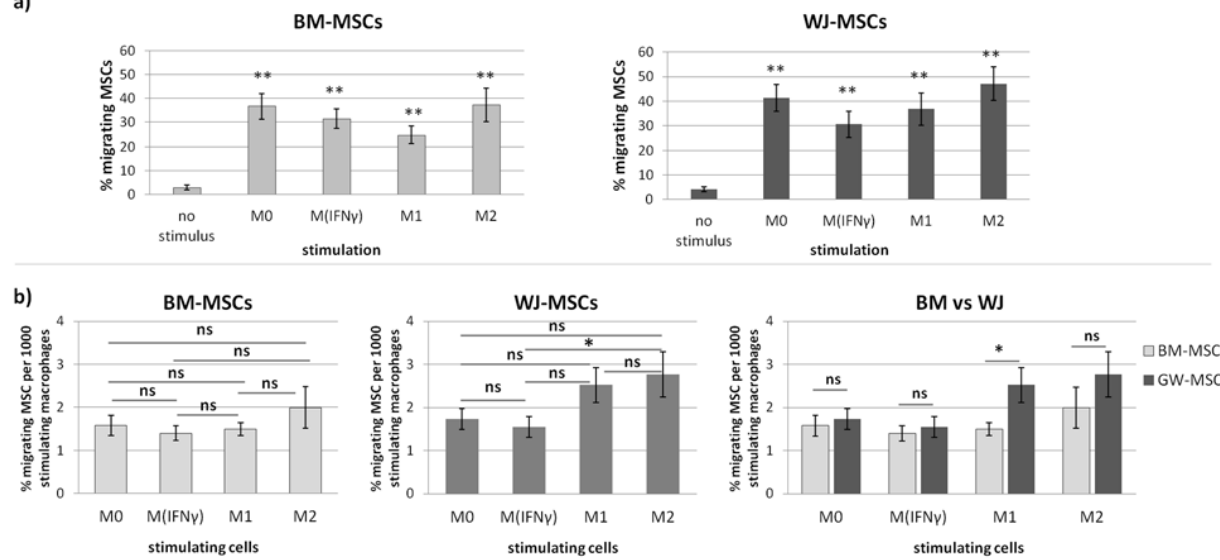
Figure 8. The effect of different subsets of macrophages on the chemotactic activity of human BM-MSCs and WJ-MSCs assessed using the trans-well migration assay (8 μ m). ( a ) The migrating BM-MSCs and WJ-MSCs stimulated by different subsets of macrophages (M0—unstimulated macrophages, M IFN γ —IFN γ stimulated, M1—IFN γ /LPS-stimulated, and M2- IL-4/IL-10 stimulated) macrophages in comparison to the unstimulated control (no stimulus—migration to the empty well). Bars represent the mean percentage (± SEM) of MSCs found in the lower compartment after 48 h (with respect to the number of cells seeded in the upper compartment at the start of the experiment); Data analyzed using T-test for related data in comparison to unstimulated control; ** p < 0.01. ( b ) The comparison of different subsets of macrophages as stimu- lants of MSCs chemotaxis. The data presented as the mean percentage (± SEM) of MSCs found in the lower compartment after 48 h (with respect to the number of cells seeded in the upper compartment at the start of the experiment) per 1000 stimulating cells. Within one MSC type, data were analyzed using one-way ANOVA with Tukey post-hoc correction. The comparison of BM-MSCs and WJ-MSCs within one stimulus was performed using a T-test for independent data (normal data distribution in all groups confirmed with Shapiro–Wilk test). * p < 0.05; ns—statistically not significant. Data collected from 4 independent experiments, total n = 12. This basal rate of migration did not differ significantly between BM-MSCs and WJ- MSCs ( p > 0.05) (Figure 8a). If macrophages (M0, M IFN γ , M1, or M2) were used as stimu- lants, the percentage of migrating BM-MSCs increased to 36.6%, 31.4%, 24.8%, and 37%, respectively ( p < 0.01 for all groups in comparison to the unstimulated control). The per- centage of WJ-MSCs in parallel experiments increased to 41.3%, 30.5%, 36.7%, and 47.1%, respectively ( p < 0.01 for all groups in comparison to the unstimulated control) (Figure 8a). In the second step, different subsets of macrophages were compared among each other as stimulants of MSCs. In this analysis, the number of stimulating macrophages was addi- tionally taken into account. For both BM-MSCs and WJ-MSCs, M2 appeared to be the strongest chemoattractant among analyzed subsets of macrophages (Figure 8b). However, in the case of BM-MSCs, no statistically significant differences were observed between groups (Figure 8b). In the case of WJ-MSCs, M2 was found to be a significantly stronger chemoattractant than M IFN γ macrophages ( p = 0.02). No other significant differences be- tween groups were noted in regards to WJ-MSCs (Figure 8b). Finally, the relative migra- tion of BM-MSCs and WJ-MSCs under stimulation with different subsets of macrophages was compared. This analysis showed that WJ-MSCs were significantly more prone to re- spond to chemotactic signals released by M1 macrophages than BM-MSCs (1.7-fold dif- ference, p < 0.04, Figure 8b). The other subsets of macrophages attracted BM-MSCs and WJ-MSCs to a similar extent.